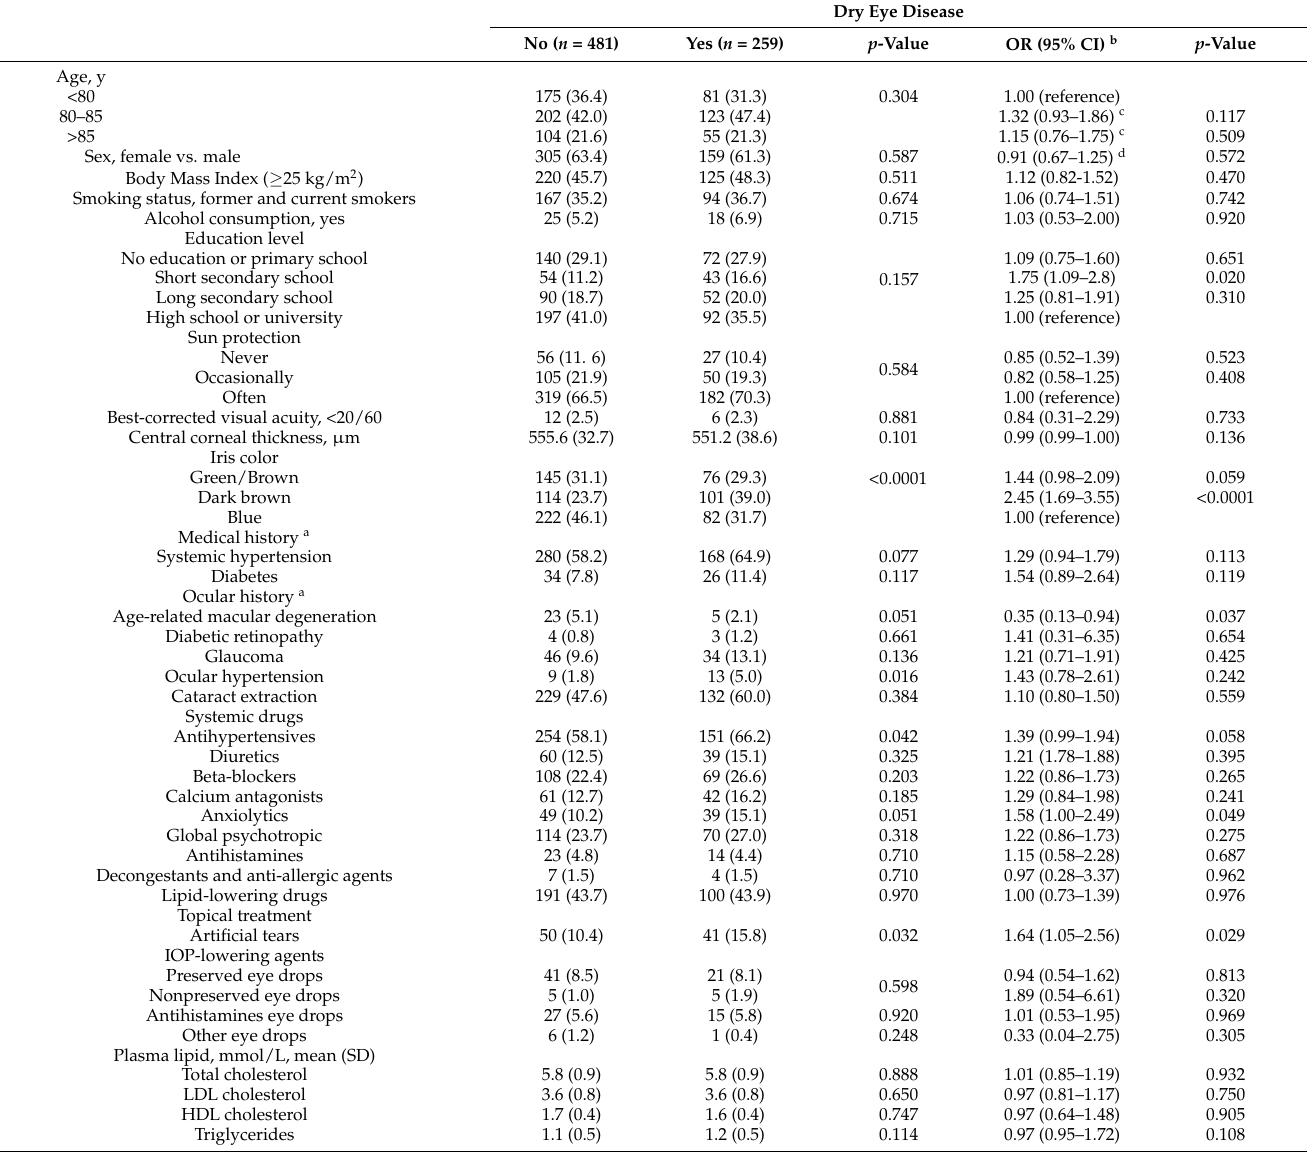
Table 2. Characteristics of participants and age- and sex-adjusted associations according to the presence of dry eye disease, n =